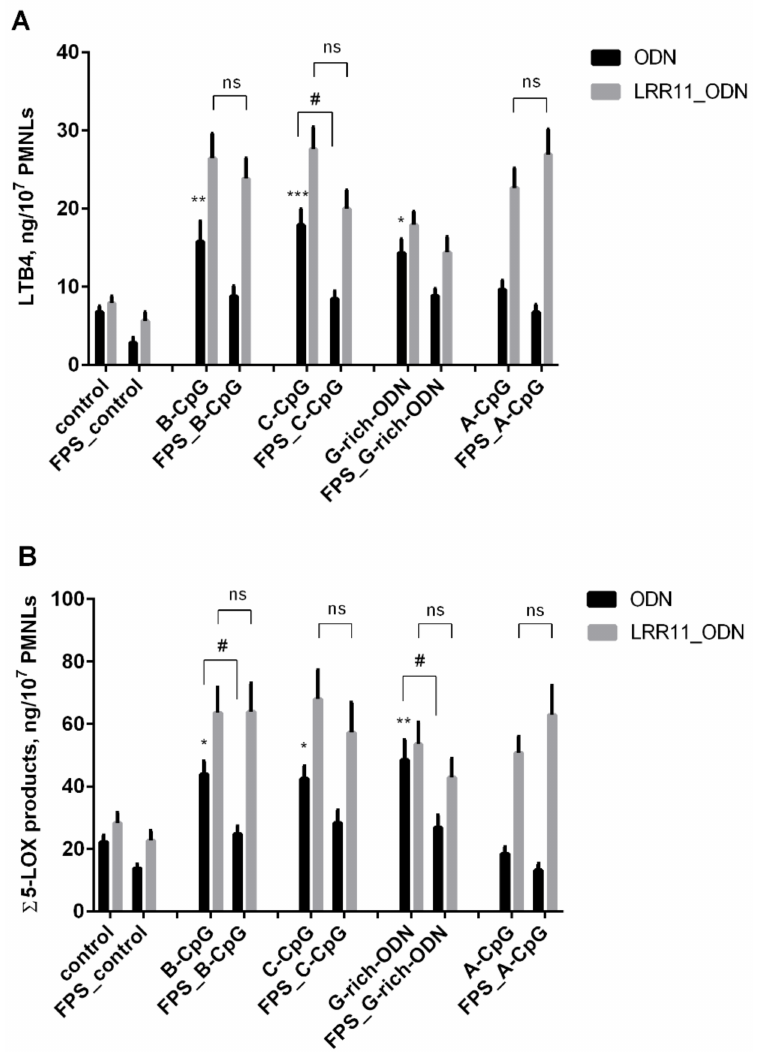
Figure 3. Synthesis of the 5-LOX metabolites in PMNLs exposed to opsonized S. typhimurium bacteria in the presence of the RAGE antagonist FPS-ZM1. PMNLs (2 × 10 7 ) were incubated for 15 min at 37 ◦ C without additives or with 0.15 µ M FPS-ZM1, for the next 20 min the mixture was incubated with 1 µ M ODNs without (black bars) or with 1 µ M LRR11 (gray bars) before adding 5 × 10 8 S. typhimurium for 15 min. In control samples, Hanks’ solution was added instead of ODNs. The 5-LOX products were determined using HPLC. Graphical data are presented for LTB4 ( A ) or the sum of LTB4 and its isomers, ω -OH-LTB4 and 5-HETE, designed as Σ 5LOX products ( B ). Values indicate mean ± SEM for four independent experiments. * p < 0.05, ** p < 0.01, *** p < 0.005 versus the corresponding control. # p < 0.05, ns–no significant difference, for pairs of data compared as indicated by one-way ANOVA followed by Tukey’s multiple comparison